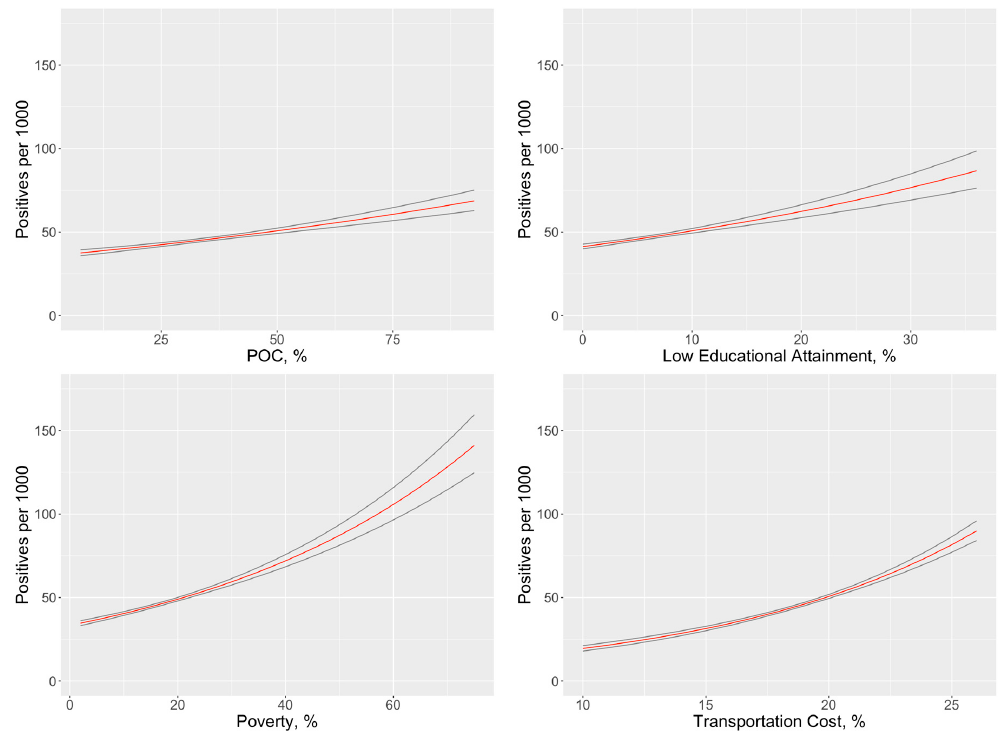
Figure 3. Influence of community-level factors on test positivity rates, adjusting for other factors in the multivariate model, with main estimate shown in black and the 95% CI in red. Table 3. Results of multivariate model of COVID-19 test positivity based on SES and race/ethnicity variables. Estimates and 95% CIs are the exponentiated coefficients of the Poisson model, with statistically significant associations indicated with an asterisk.